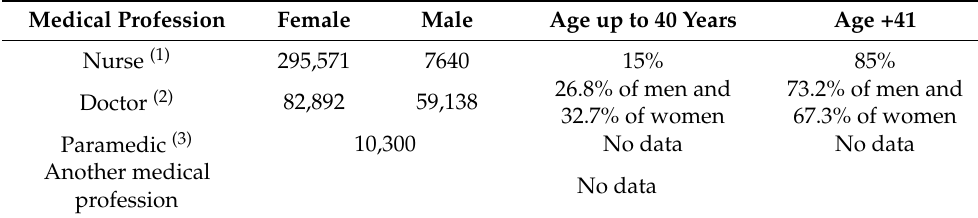
Table 1. Classification structure of selected healthcare providers in